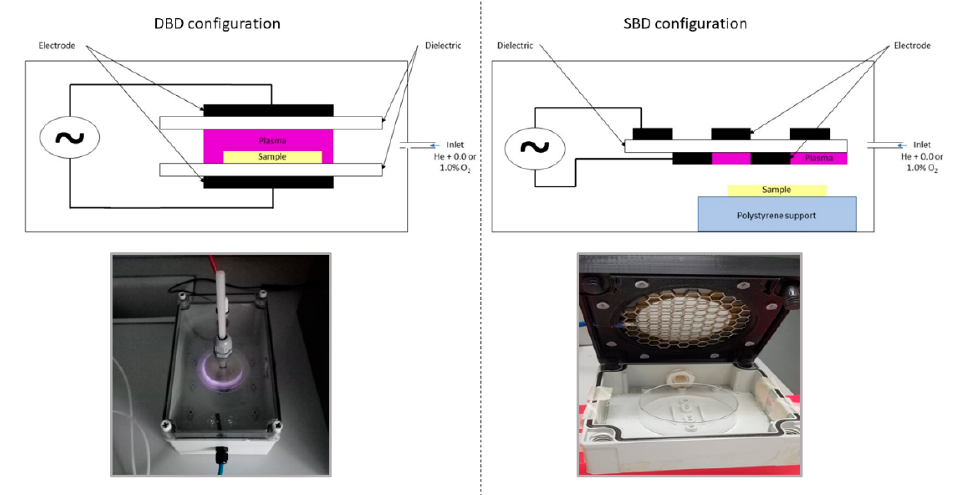
Figure 1. Schematic representation and photographic image of the DBD and SBD electrode configurations used within this study.